Question: In a single sentence, describe what this figure presents.
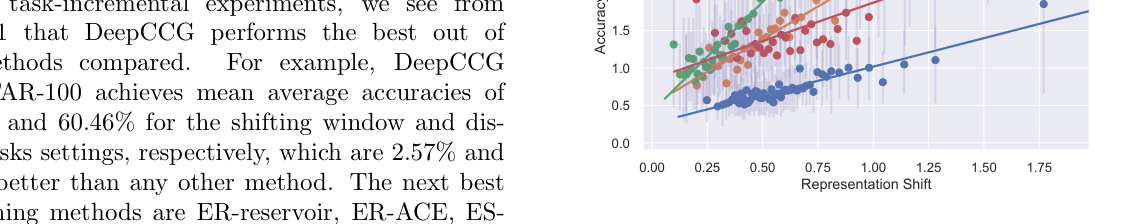
Answer: Binned scatter plot showing for the Mini- ImageNet task-incremental disjoint-tasks setting the change in accuracy against the mean change in repre- sentation after learning on a batch for the test data of the first task. The plot shows that for a given shift in representation the accuracy of DeepCCG changes the least.